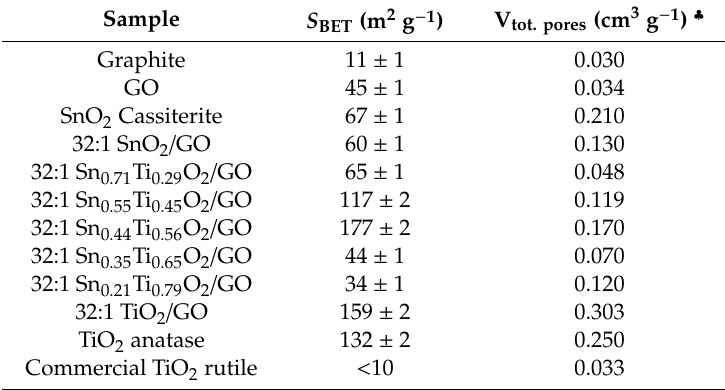
Table 1. Surface area ( S BET ) and total pore volume (V tot. pores ) by BET-BJH analysis, together with the relative standard deviations directly given by the instrumental